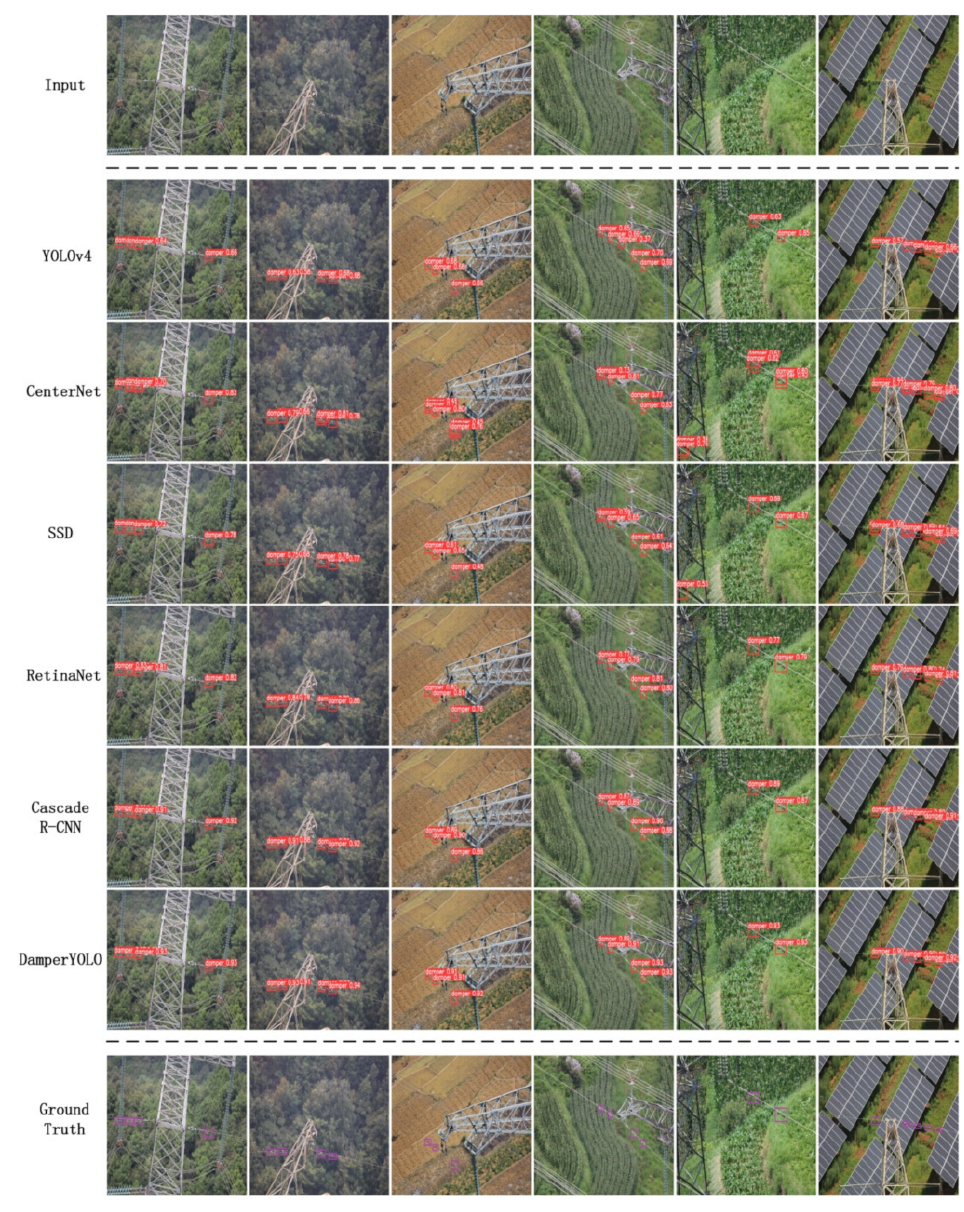
Figure 5. Test examples of each model on the DamperDetSet dataset. Experimental results show that the performance of DamperYOLO is similar to Cascade R-CNN, better than SSD, RetinaNet and YOLOv4 in one-stage class, and